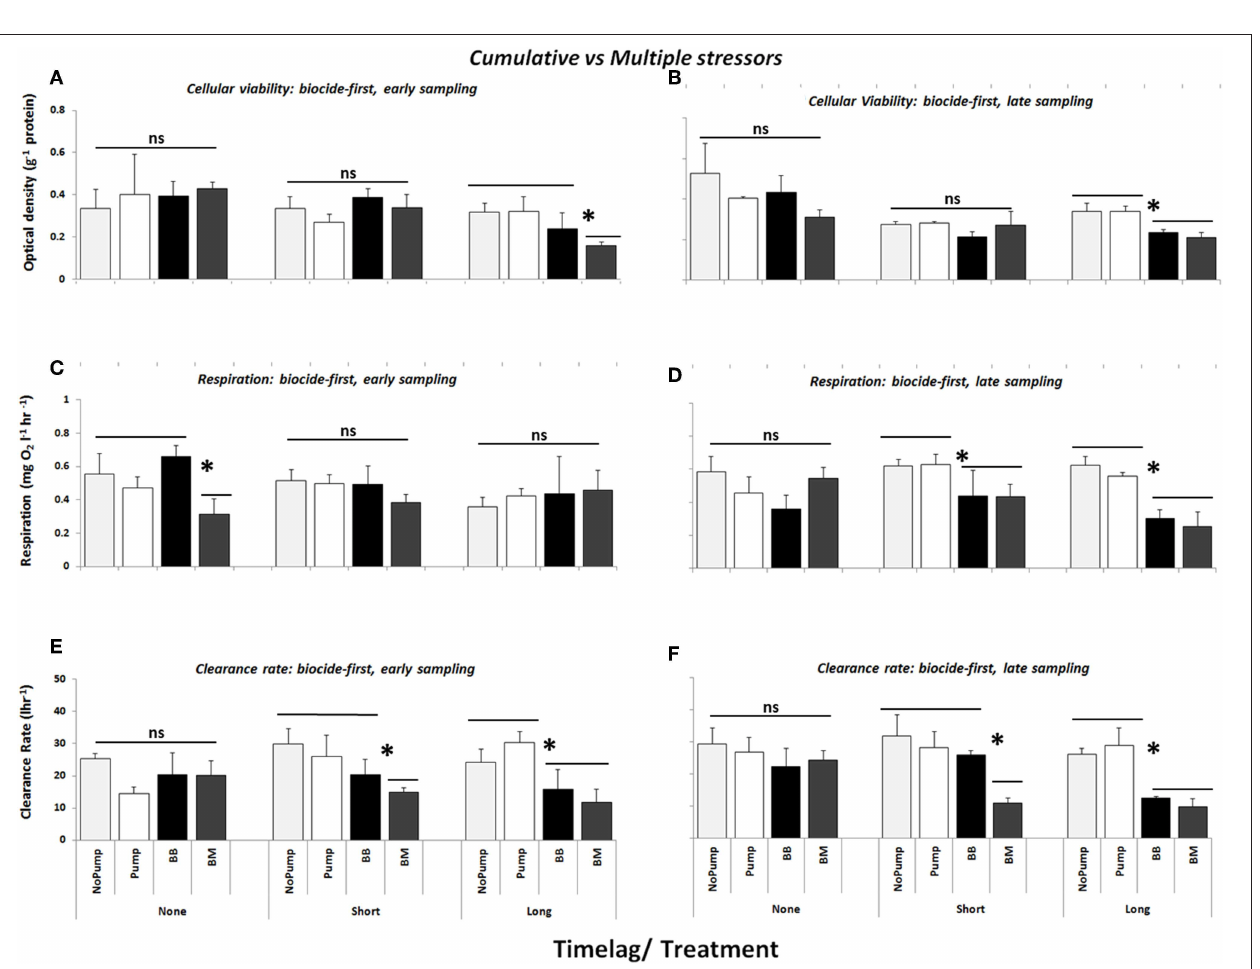
Frontiers in Ecology and Evolution |